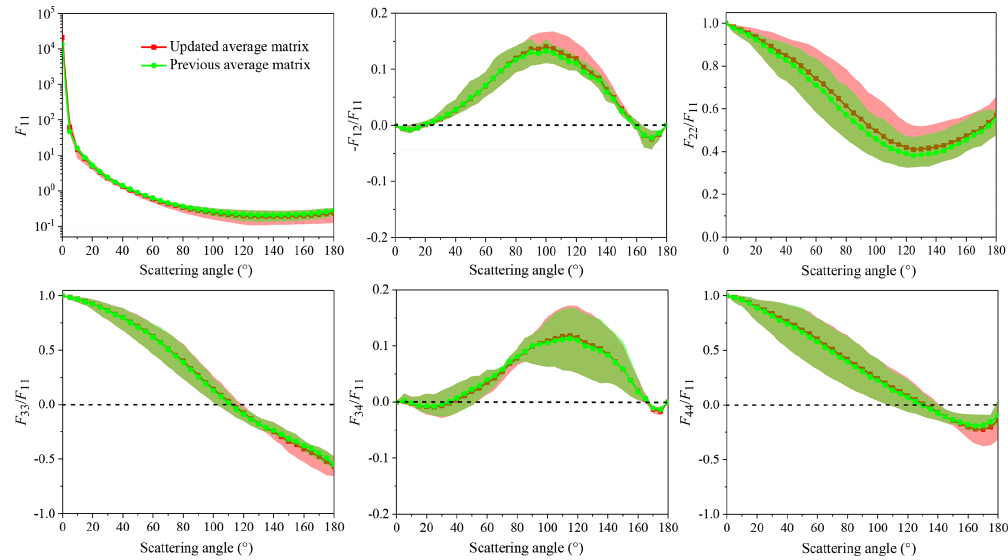
Figure 6. Previous average scattering matrix (green lines and solid circles) (Liu et al., 2019) and updated average scattering matrix (red lines and solid squares) for loess dust. Reddish and green shadows stand for the areas covered by results for different loess samples with or without pristine loess included,